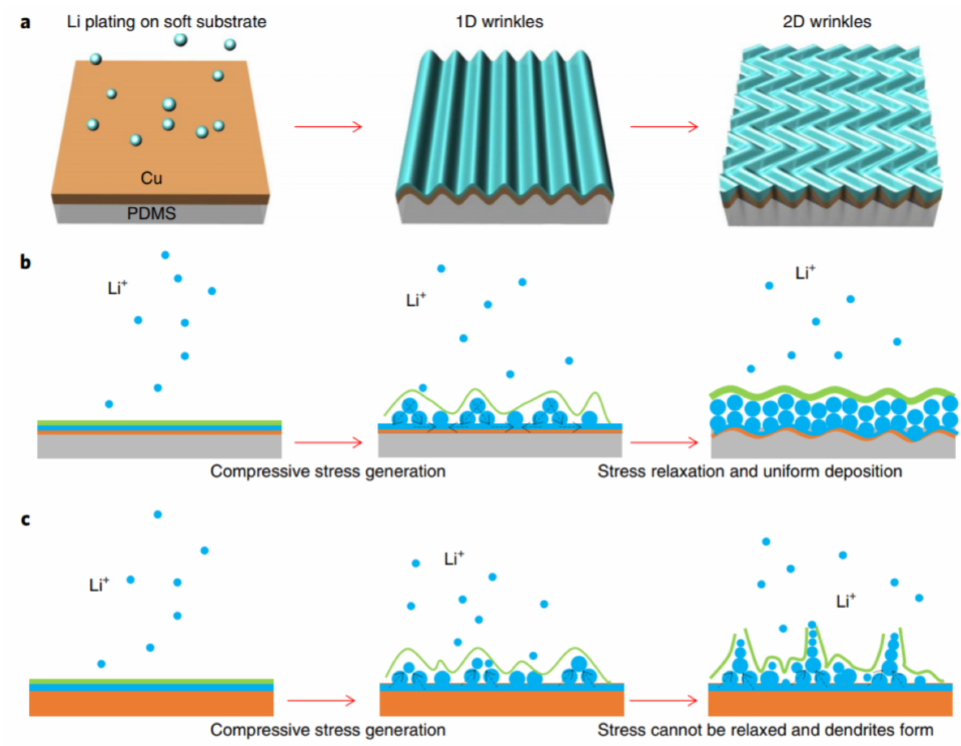
Figure 25. ( a ) Schematic view of wrinkle formation based on substrate types ( b ) Generation and relaxation of compressive stress in Li-Cu soft substrates ( c ) Formation of dendrites and relaxation of compressive stress in Li-Cu hard substrate (adapted with permission from [251]. Nat. Energy, Springer Nature,